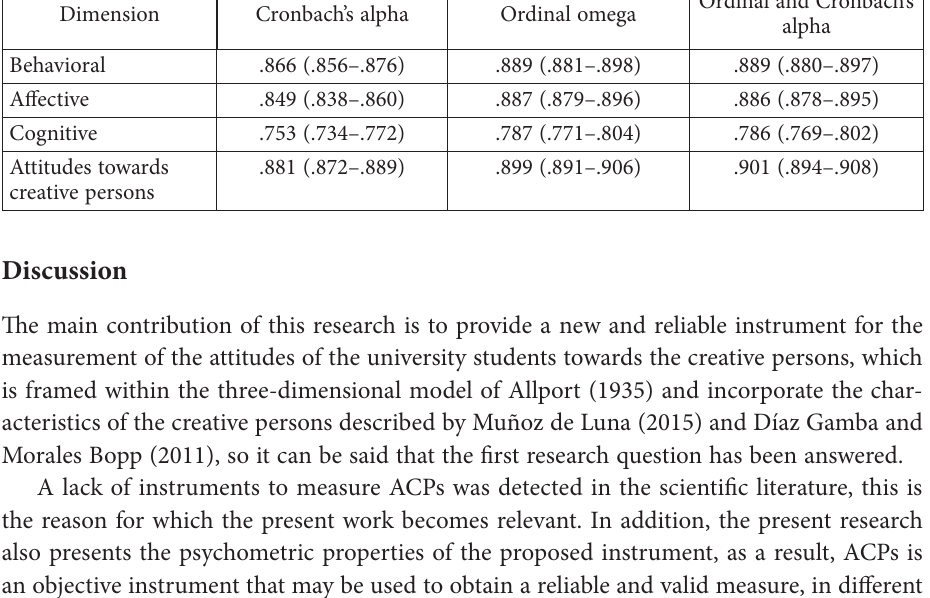
Ordinal and Cronbach’s alpha